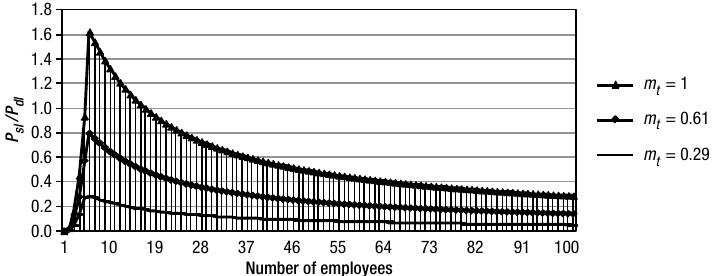
Fig. 2. Ratio between knowledge potential synergy and employees’ knowledge potential, when the number of employees is changing (when P